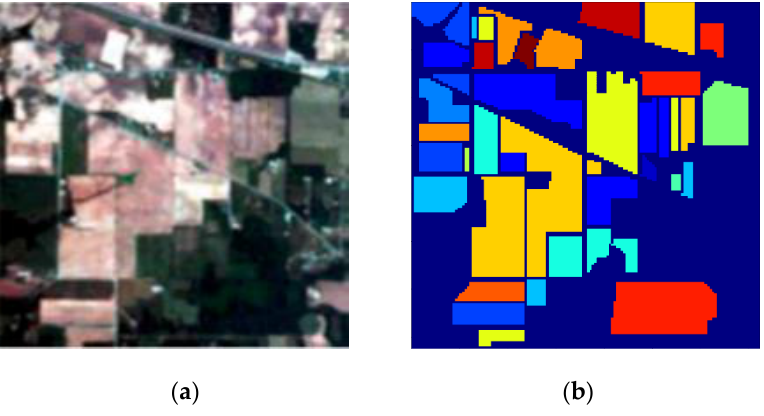
Figure 6. Indian Pines dataset. ( a ) The false-color image. ( b ) The ground-truth